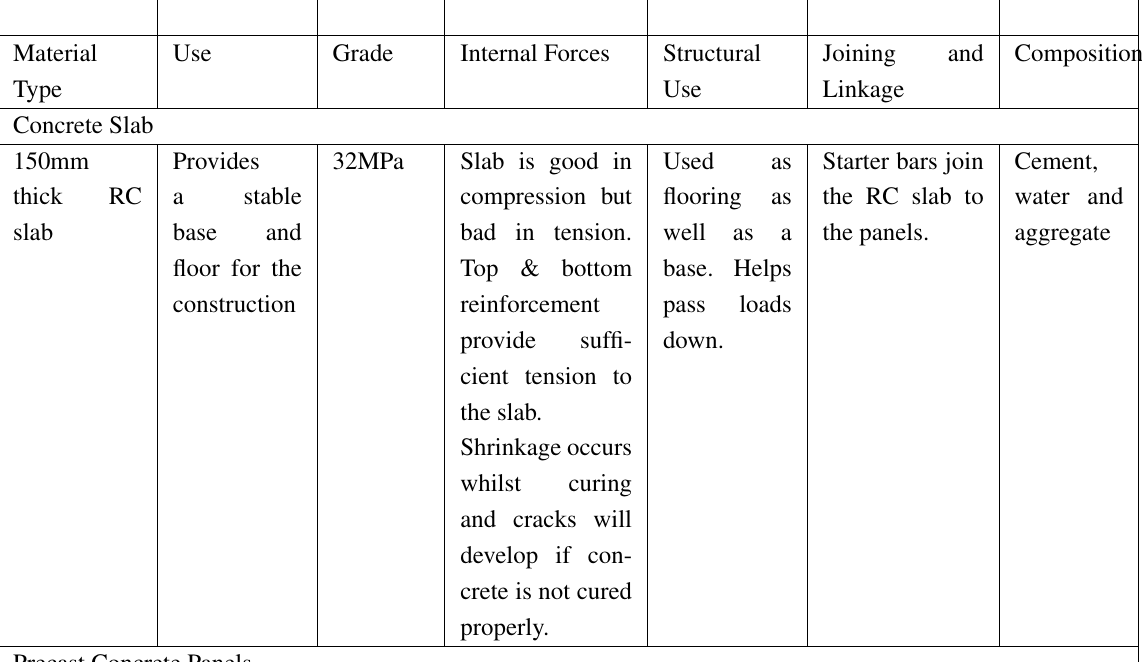
Table 2. Concrete usage in